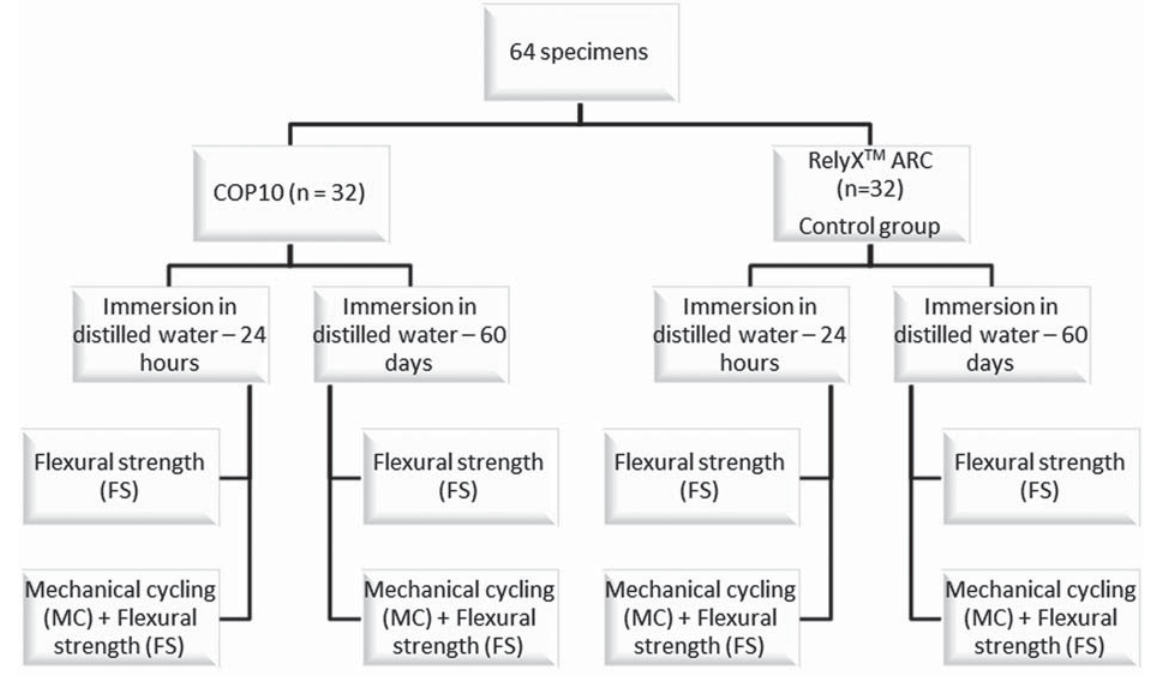
Figure 1- Flow chart of the